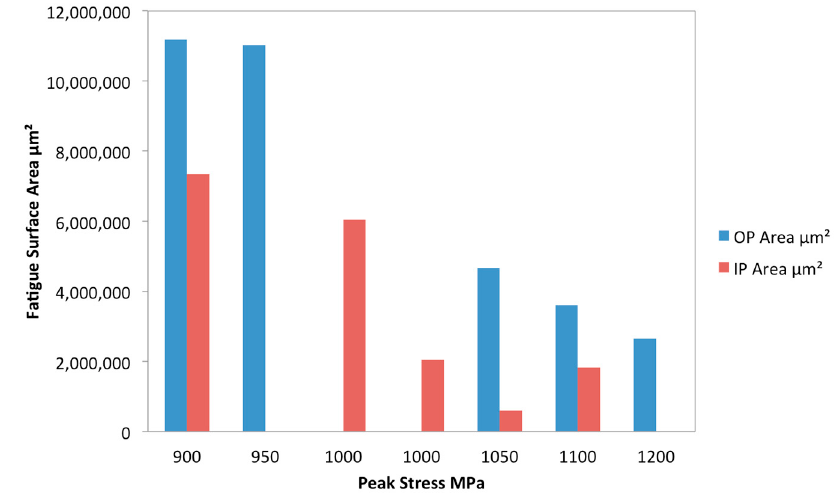
Figure 9. Bar chart showing the fatigue crack area against peak applied stress for all TMF tests conducted where fatigue cracks were present.